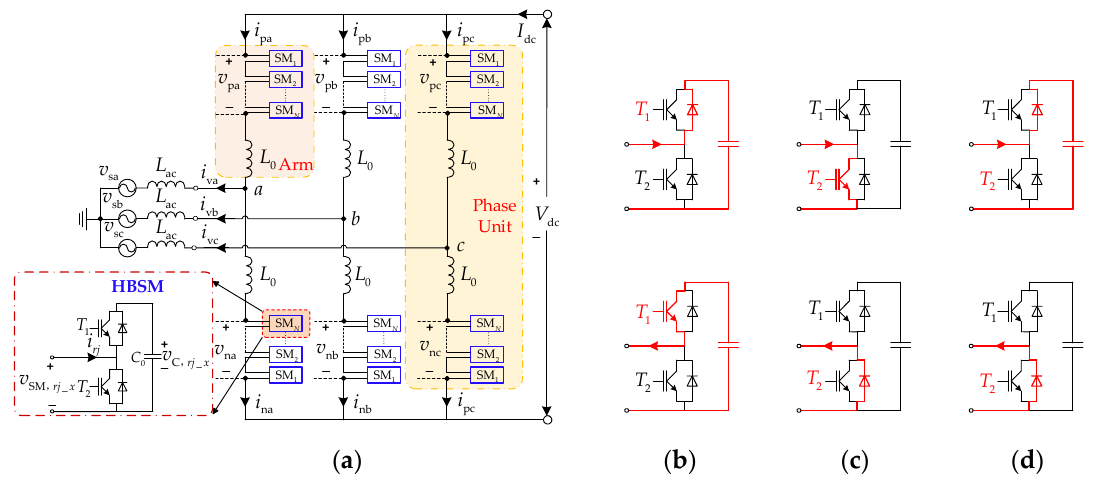
Figure 1. The general structure of the modular multilevel converters (MMC), and three modes of half-bridge submodules (HBSM): ( a ) The general structure of the MMC; ( b ) Inserted mode; ( c ) Bypassed mode; ( d ) Blocked mode.